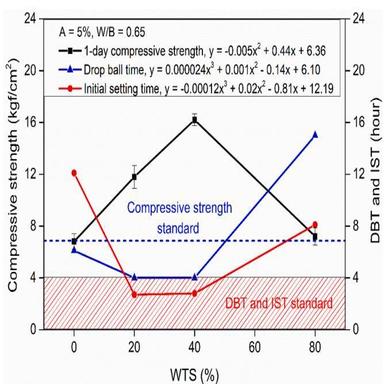
The influence of WTS content on DBT, IST, and 1-day compressive strength in CLSM of 0.65 w/b and 5% A.